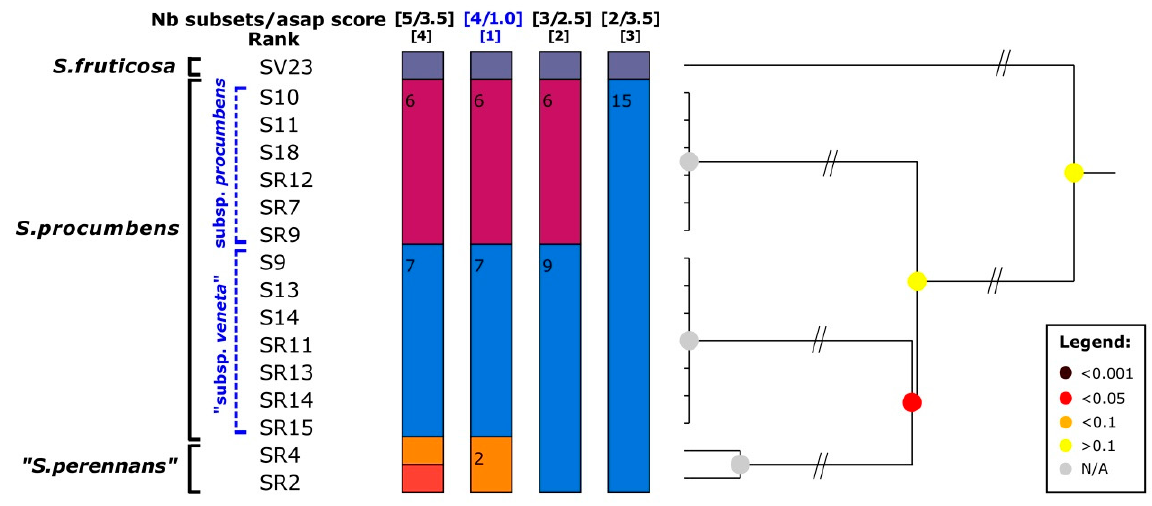
Figure 6. Phylogenetic reconstruction based on the psb A -trn H intergenic spacer. For each node, the support values from ML bootstrap and MP bootstrap and BI posterior probabilities are reported, respectively. Only bootstrap supports ≥ 50% and posterior probabilities ≥ 0.70 are shown. Values for nodes that obtained support in only one of the phylogenetic analyses were omitted. Scale bar represents expected number of nucleotide substitutions per site. The results of the species delimitation tests are reported on the right.